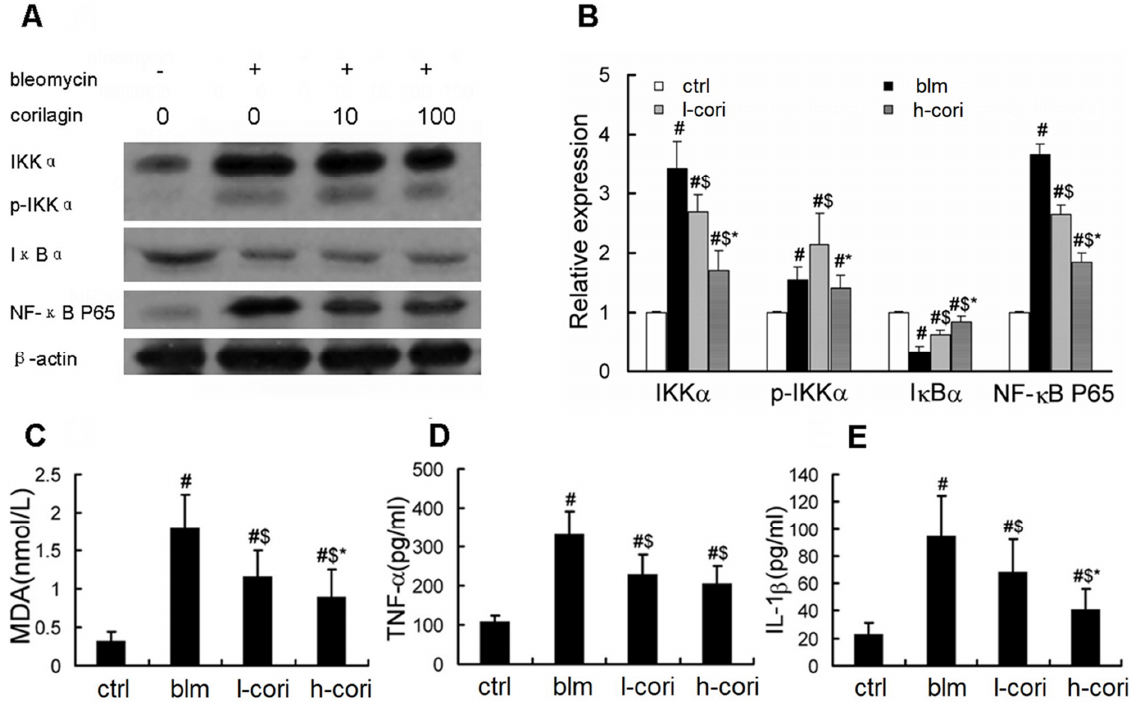
Figure 7. Corilagin reduced bleomycin-induced lipid peroxidation and NF- κ B